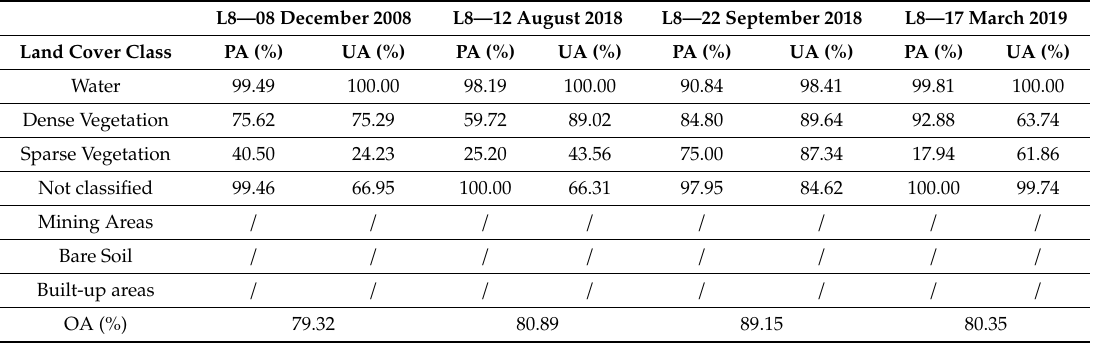
Table 9. OA, PA, and UA obtained through the application of Green Optimized Soil Adjusted Vegetation Index (GOSAVI) on the data acquired by Landsat 8 mission. UA, user’s accuracy; PA, producer’s accuracy; OA, overall